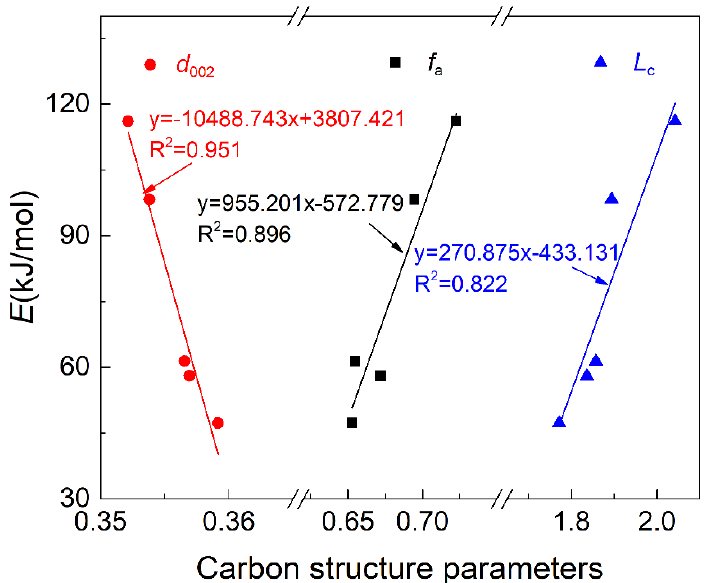
Figure 10. Relationship between activation energy and coal structure from XRD analysis.